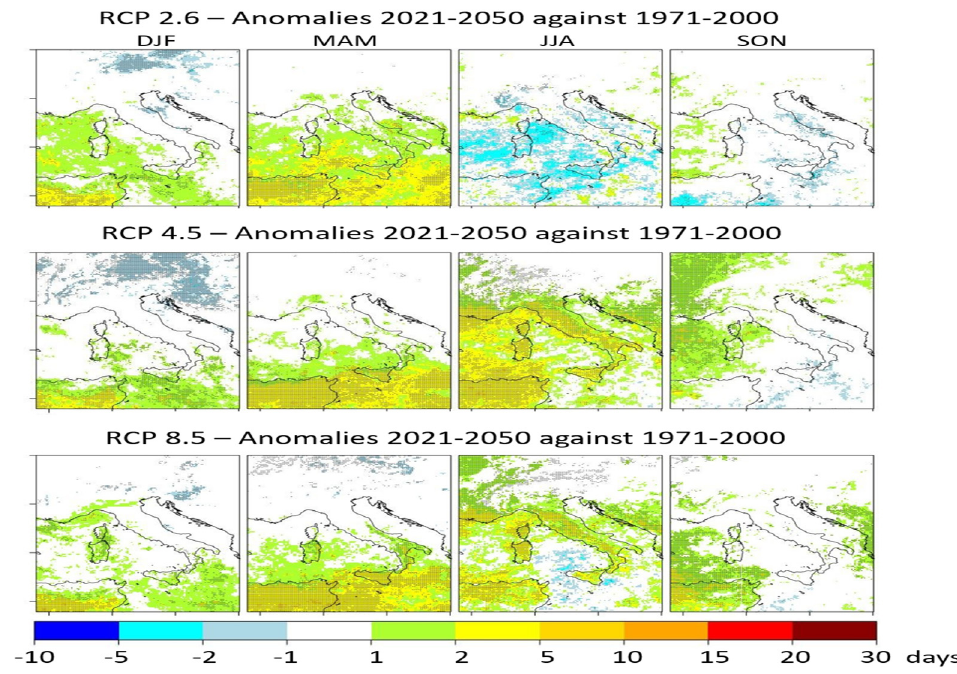
Figure 10. Seasonal CDD anomalies (unit = number of days), expressed as difference between the number of events projected in the future period 2021–2050 (DJF, MAM, JJA, SON, respectively, from first to fourth column) and the events computed in the reference period 1971–2000 under RCP 2.6 (top), RCP 4.5 (center), RCP 8.5 (bottom) configurations.